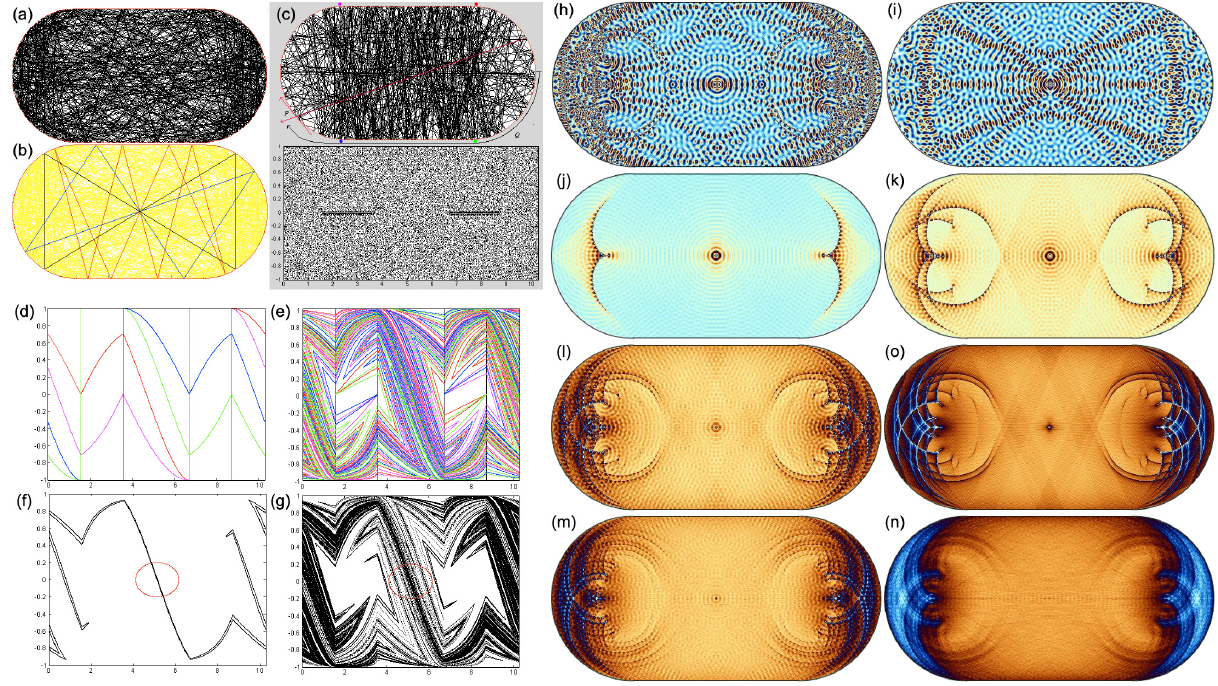
Figure 9: (a) Extended orbit of 200 reflections in both directions from a close homoclinic recurrence generating in (b) the repelling bow tie orbit representation (black) later shows heteroclinic recurrence to other orbits, a related period 4 skewed bow tie (blue) and a period 8 orbit (red). Because the dynamics is conservative and area in phase space is conserved, the chaotic process consists of horseshoe saddles and repulsion in one eigenspace is compensated by attraction on the other. (c) Single directed orbit of 500 reflections from (0 , 1) with direction (1 , − 3) can be transformed by the coordinate transformation shown into a momentum-position representation in which P is the cosine of the angle of the ray to the tangent and Q is the perimeter distance e.g. from the mid-point of the right circular arc. This 2D coordinate system results in the discrete dynamic below for 50000 iterations, in which phase space is ergodically (pseudo-randomly) filled except for a diminishing pair of central regions corresponding to the neighborhood of vertical stable orbits. (d) The one-step partition of phase space induced by colouring all the orbits fanning o ff ( ± 1 , ± 1 ), colour-coded as in the discussion. (e) the corresponding partition for four steps. (f) The region mapped from the red ellipse in two reflection steps becomes fractally recurrent after six steps (g). (h) Semiclassical superimposed periodic ray trace of the stadium from a fan of rays at the centre with propagator having period a fraction of the stadium dimensions for 4 reflections. (i) The wave function cellular automaton, with a circular wave packet generator, having a similar fractional period, relative to the stadium width, to the semiclassical example. (j-o) Semiclassical superimposed periodic ray trace of the stadium from a circular wave generator at the centre with period a fraction of the stadium dimensions for (j) 2, (k) 3, (l) 4, (m) 5, and (n) 8 reflections. Rather than highlighting the scars around existing periodic orbits, the method highlights periodic versions of the successive caustics caused by repeated reflection also evident in (o), the classical ray trace for 4 reflections, shown for